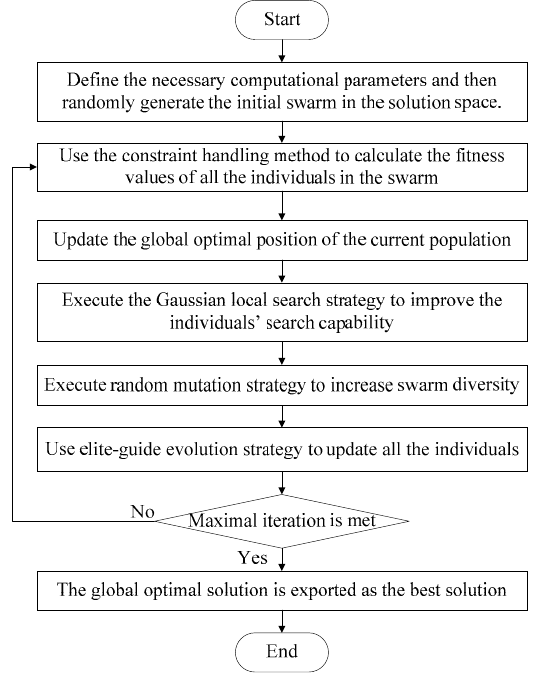
Figure 6. The flowchart of HSCA for the peak operation of cascade hydropower reservoirs.